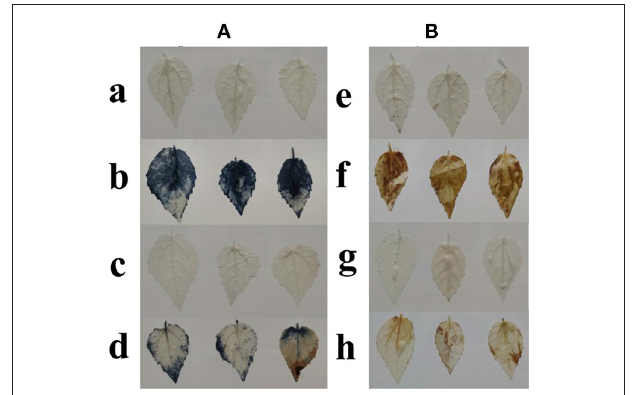
FIGURE 8 | Histochemical staining by nitro blue tetrazolium (NBT) and 3,3 ′ -diaminobenzidine (DAB). (A) NBT staining. a: Leaves of wild type (WT) Populus davidiana × P. alba var. pyramidalis Louche (PdPap) without infection, b: Leaves of WT PdPap with Fusarium oxysporum , c: Leaves of transformants without F. oxysporum , d: Leaves of transformants with F. oxysporum; (B) DAB staining. e: Leaves of WT PdPap without infection, f: Leaves of WT PdPap with F. oxysporum , g: Leaves of transformants without F. oxysporum , h: Leaves of transformants with F. oxysporum. Staining intensities of WT and transformants under infection of F. oxysporum are similar, but greatly increased in WT infected by F. oxysporum